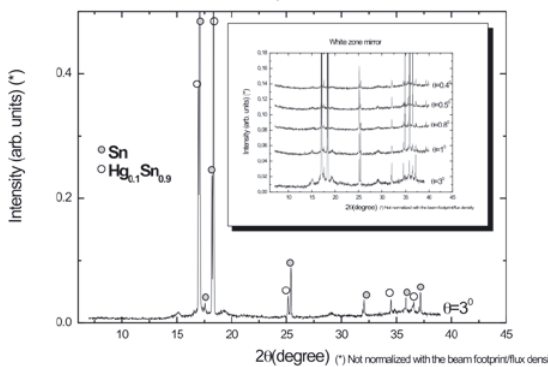
Figure 4. XRD profiles at different incidence angle φ = 0.4º to 3º of Sample 1